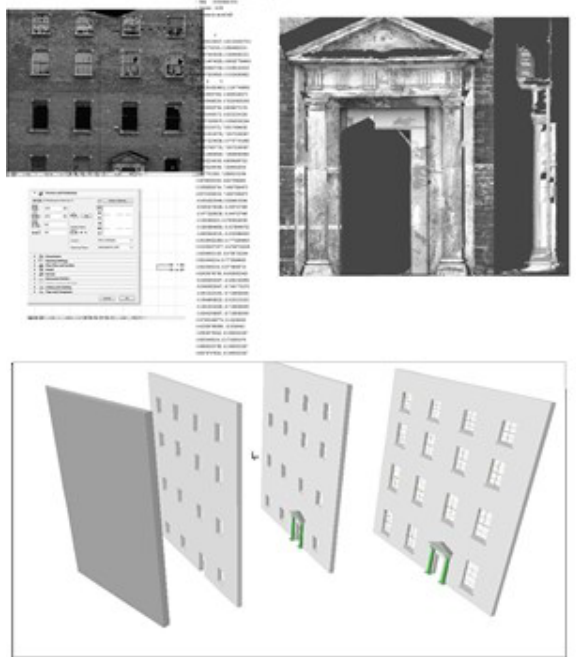
Figure 12: Mapping Library Objects onto point clouds Manual